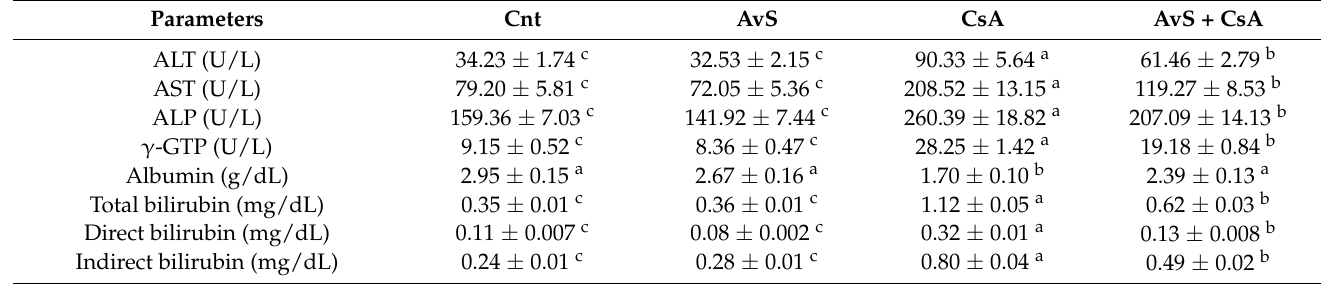
Table 3. Effect of AvS treatment on liver damage parameters in CsA-induced hepatotoxicity in rats.